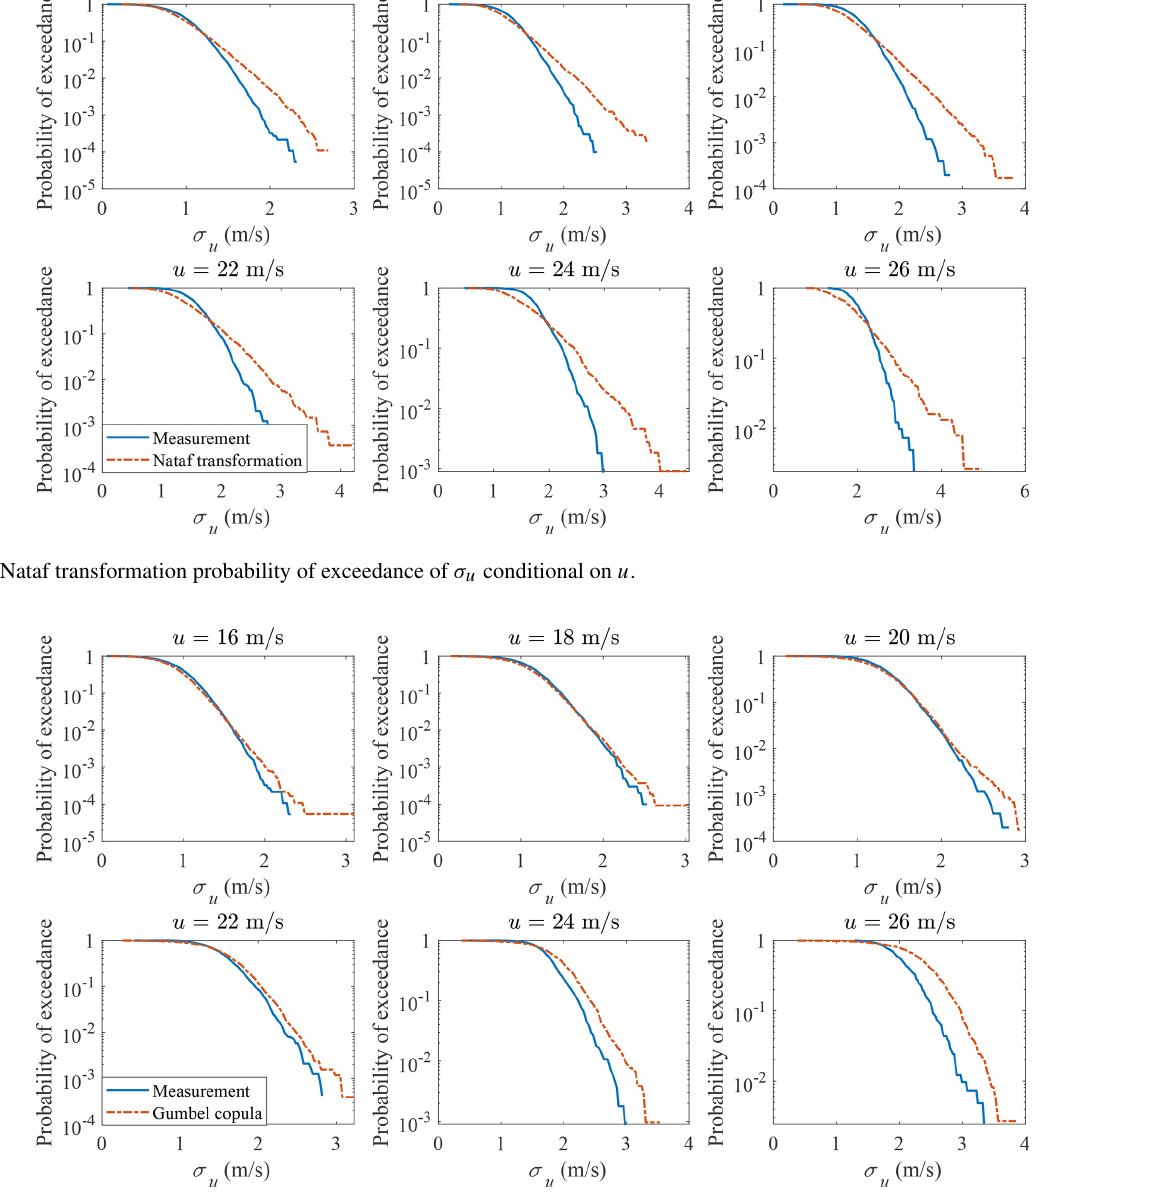
Figure 8. Gumbel copula probability of exceedance of σ u conditional on u